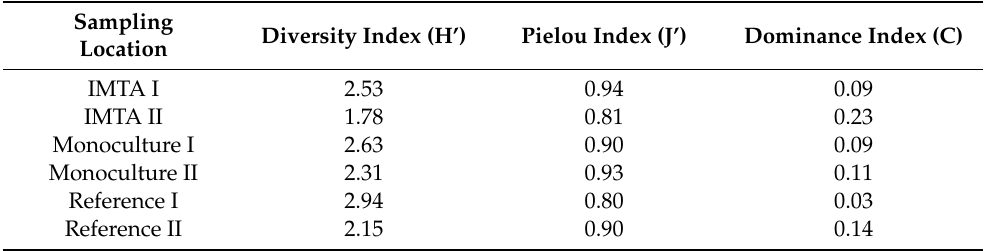
Figure 4. The 2D ordination of NMDS based on sampling time. Note: red, dashed circle: tendency of mixed grouping/clustering at the stations of , monoculture, and reference site; brown, dashed circle: tendency of separate stations of reference site; blue circle dashed line: tendency of separate stations of monoculture and sites.